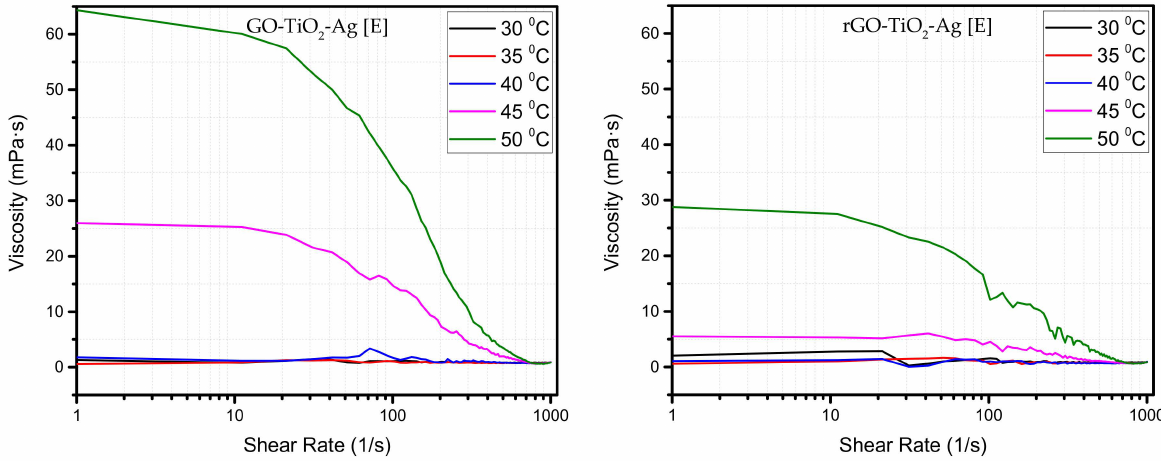
Figure 2. Shear rate vs. viscosity at different temperatures and concentrations of ternary hybrid